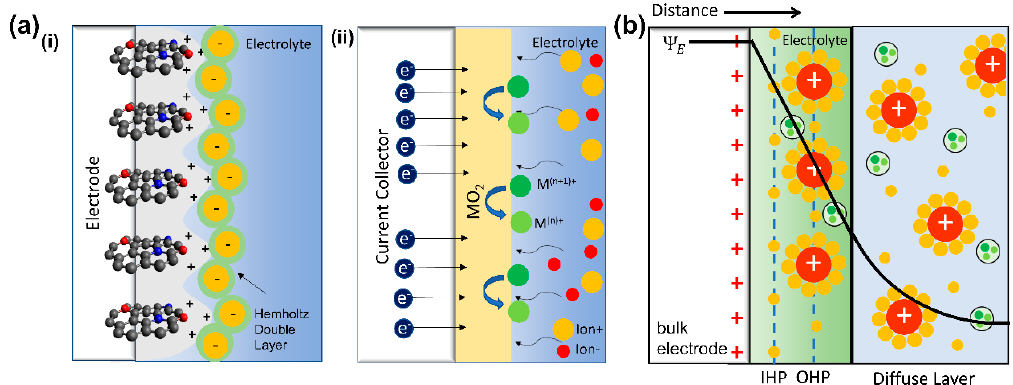
Figure 2. ( a ) Illustration of the Stern model for electrolyte ions on a charged electrode in ( i ) an electric-double-layer capacitor (EDLC) and ( ii ) a pseudo capacitance supercapacitor, as well as ( b ) a schematic model of ion distribution and mechanism.